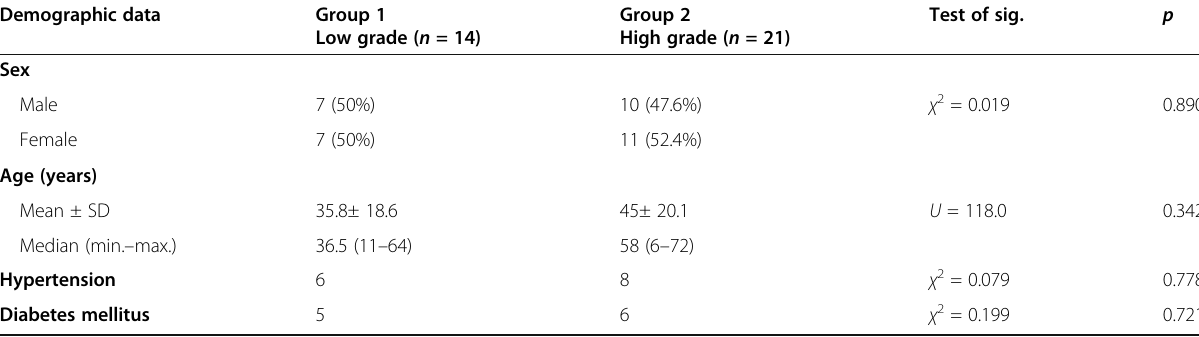
Table 1 Demographic data of the studied cases Demographic